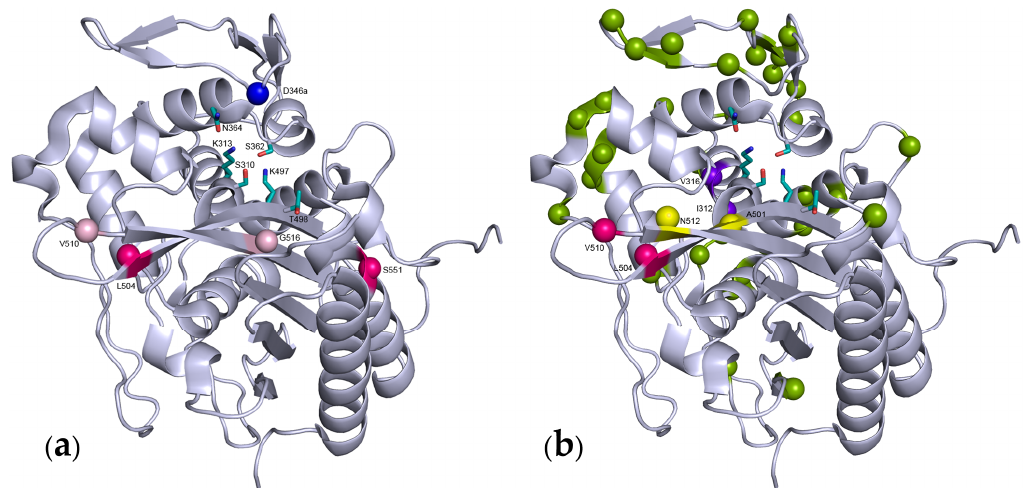
Figure 2. Ribbon representation of the transpeptidase domain of two types of N. gonorrhoeae PBP2 from resistant strains. The active site residues are shown as sticks, the substituted or inserted positions are shown by colored spheres. ( a ) Sequence XII, the D346a insertion is shown in blue; the F504L, A510V, A516G and P551S substitutions are in dull pink or magenta, to emphasize the importance of the latter substitutions in the resistance; ( b ) Distribution of the substitutions found in sequence XXXIX shown as colored spheres. Positions demonstrated as important for resistance in different studies are shown in violet [22], magenta [34] and yellow [36]. Yellow substitutions are specific of resistance to third generation cephalosporins.